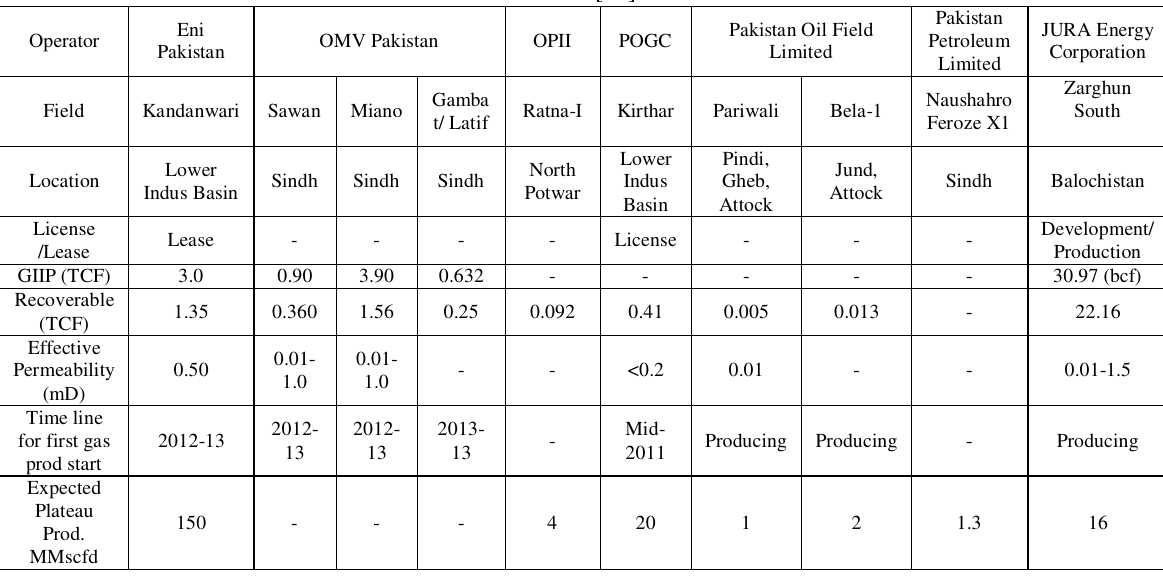
Table 1: Field-Wise Exploration and Development Status of Tight Gas Potential of Pakistan (Modified after